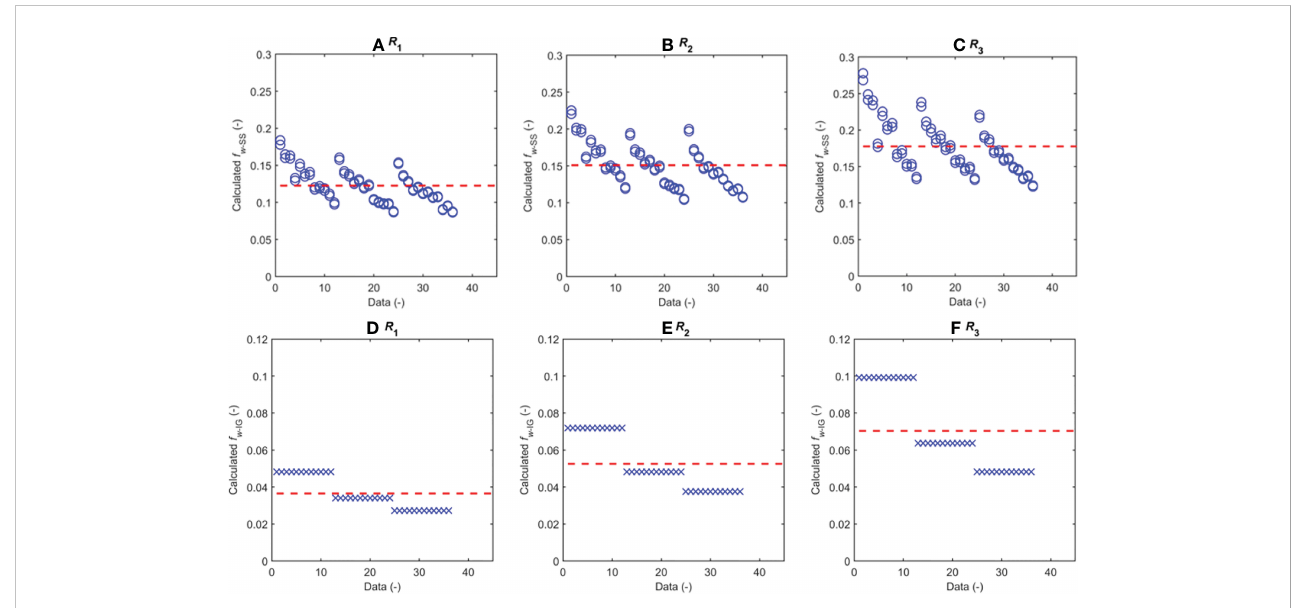
FIGURE 12 Calculated energy dissipation coef fi cient due to bottom friction for SS-waves (A – C) and IG-waves (D – F)